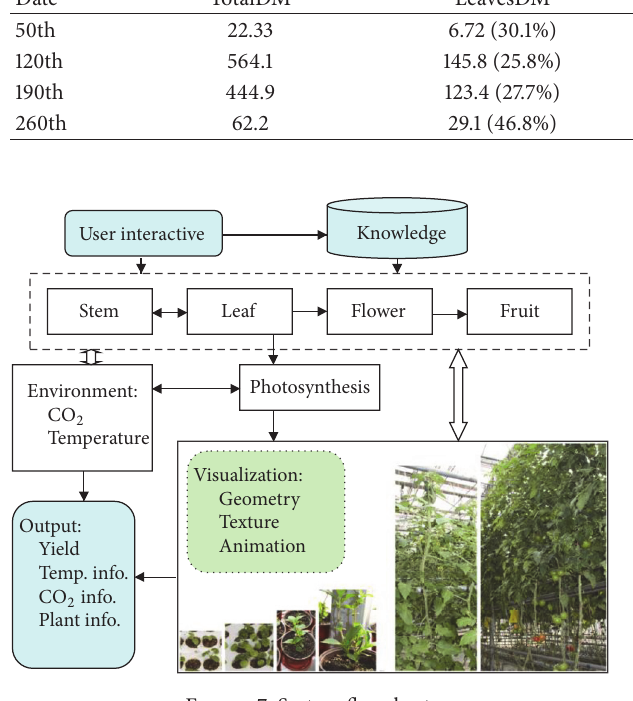
Figure 7: System